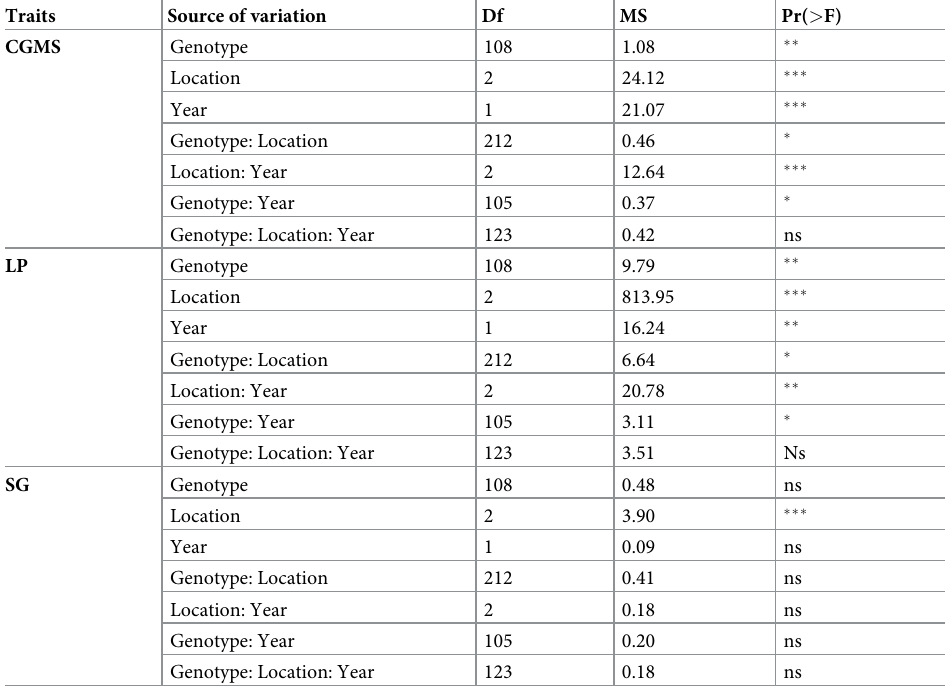
DF, degrees of freedom; MS, Mean square; F-probabilities are indicated by symbols: � P < 0.05 �� P <